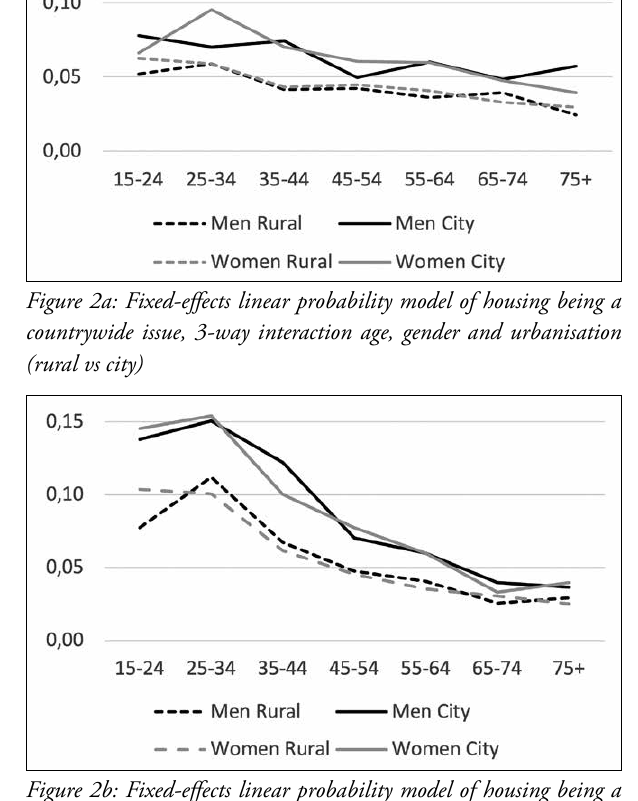
Figure 3a: Fixed-effects linear probability model of housing being a countrywide issue, 3-way interaction age, education (up to 15 v. 20+ years) and urbanisation (rural vs city)